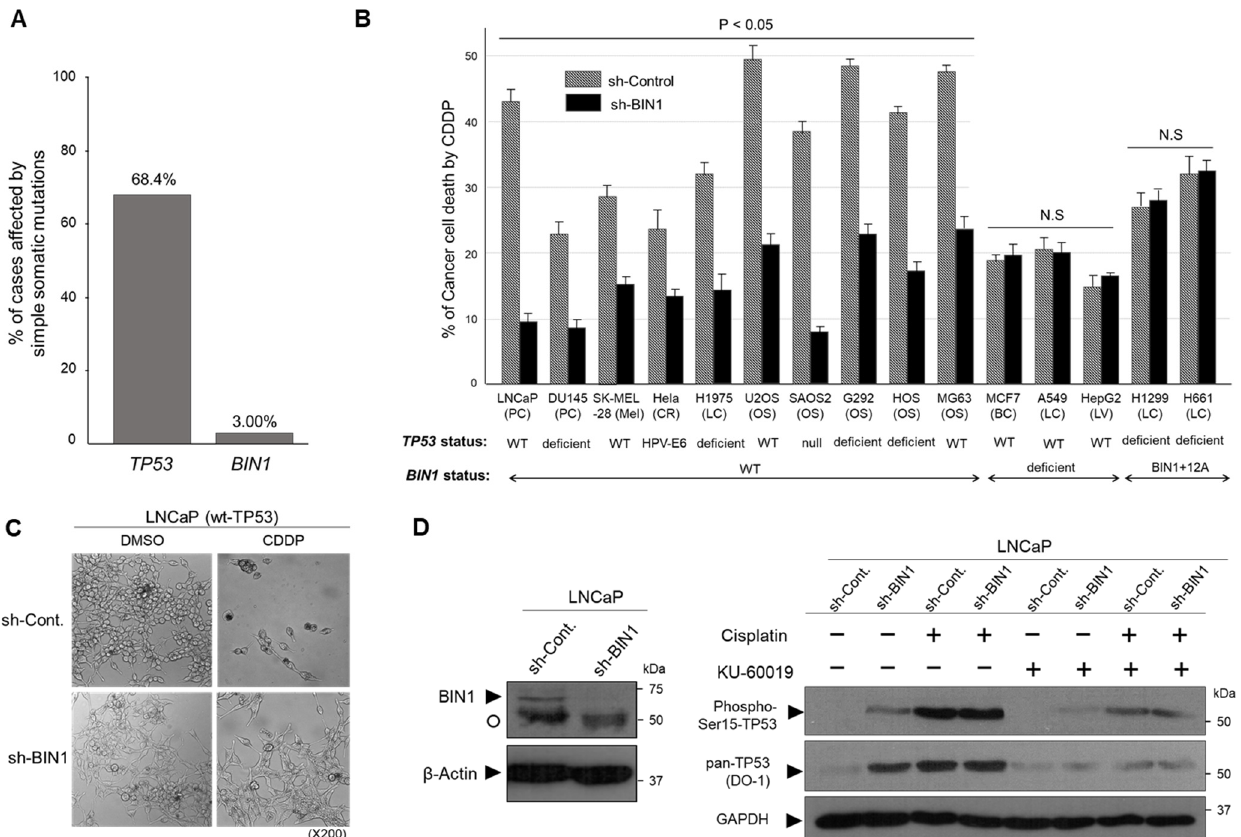
Figure 1. Forced BIN1 depletion widely decreases cisplatin sensitivity in various human cancer cell lines regardless of the TP53 gene status. ( A ) The mutation ratio of the TP53 and BIN1 genes in human solid cancer tissues is available at the US NCI Genomic DNA Commons (https://gdc.cancer.gov [accessed on 1 June 2021]). Simple somatic mutations include missense mutations, frameshift mutations, start-loss mutations, stop-loss mutations, and stop-gained mutations in multiple human cancer tissues derived from various organs, such as the lung, breast, bone marrow, colon, nervous system, ovary, kidney, skin, and prostate; ( B ) the cisplatin-induced cell death percentage (%) of cultured cancer cell lines ± sh-BIN1. The growing cancer cells were incubated with cisplatin at 2.0 µg/mL for 72 h post-transfection, during which the cells were expected to complete at least one DNA replication cycle. The floating and adherent cell fractions were combined and subjected to the trypan-blue exclusion assay. PC: prostate cancer, Mel: melanoma, CR: cervical cancer, LC: lung cancer, OS: osteosarcoma, BC: breast cancer, LV: liver cancer, HPV-E6: human papillomavirus type-18 E6 protein, NS: not (statistically) significant; ( C ) the cellular morphology of LNCaP ± sh-BIN1 cells cultured in the presence of cisplatin (CDDP) (2.0 µg/mL for 72 h) or 1/100 ( v/v ) of DMSO (dimethyl sulfoxide) was monitored under phase-contrast microscopy; ( D ) Western blotting analysis of Ser15-phosphorylated TP53 and pan TP53 proteins in LNCaP ± sh-BIN1 cell lysates in the presence (+) and absence ( − ) of 2.0 µg/mL of cisplatin and/or 3.0 µM of KU-60019, an ATM-specific small molecule inhibitor at 24 h post-treatment [25]. β -Actin and GAPDH (glyceraldehyde 3-phosphate dehydrogenase) were used as the internal loading control. An open circle indicates a non-specific protein signal.